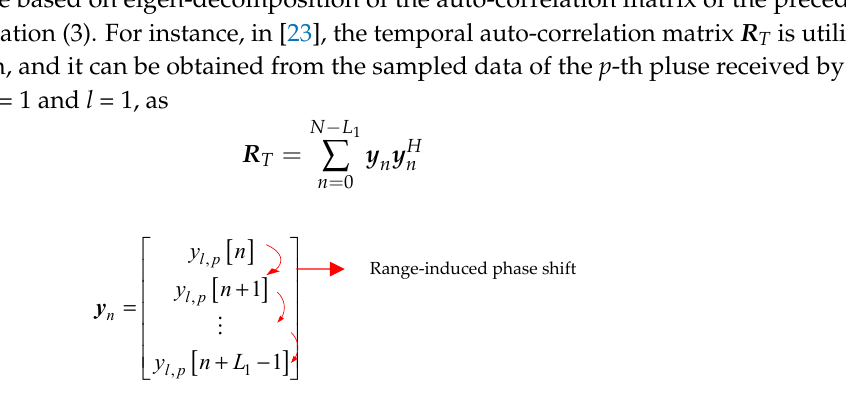
Figure 2. Illustration of the 3D phase shifts.